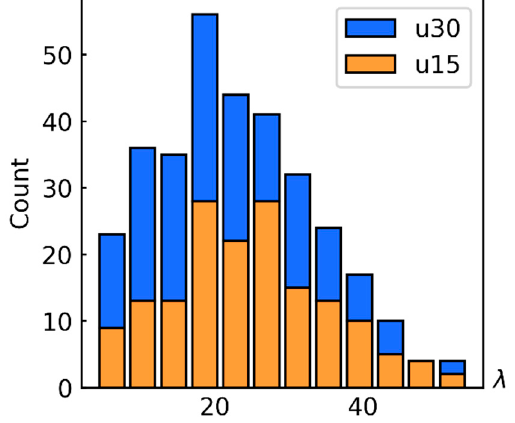
Figure 10. Distribution of diameter and length in 30% and 15% fiber mass fraction samples.